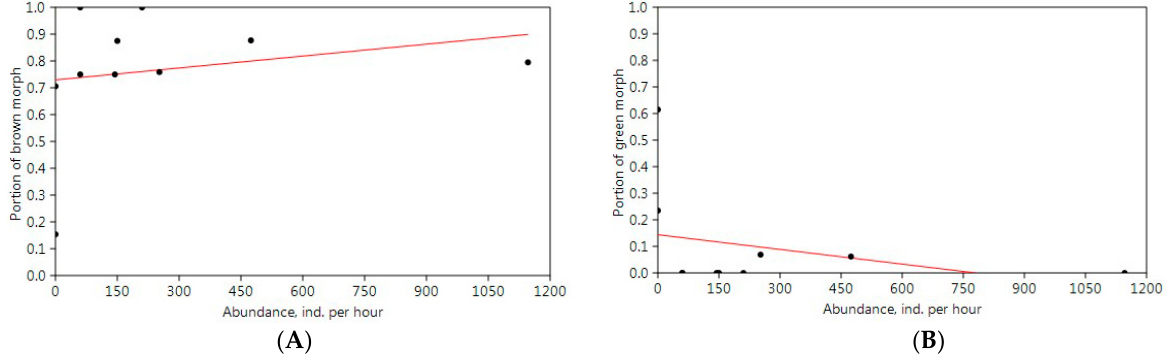
Figure 11. Multivariate regression model for two main color form variations of Oedaleus decorus in the Kulunda steppe: ( A )—brown; ( B )—green.